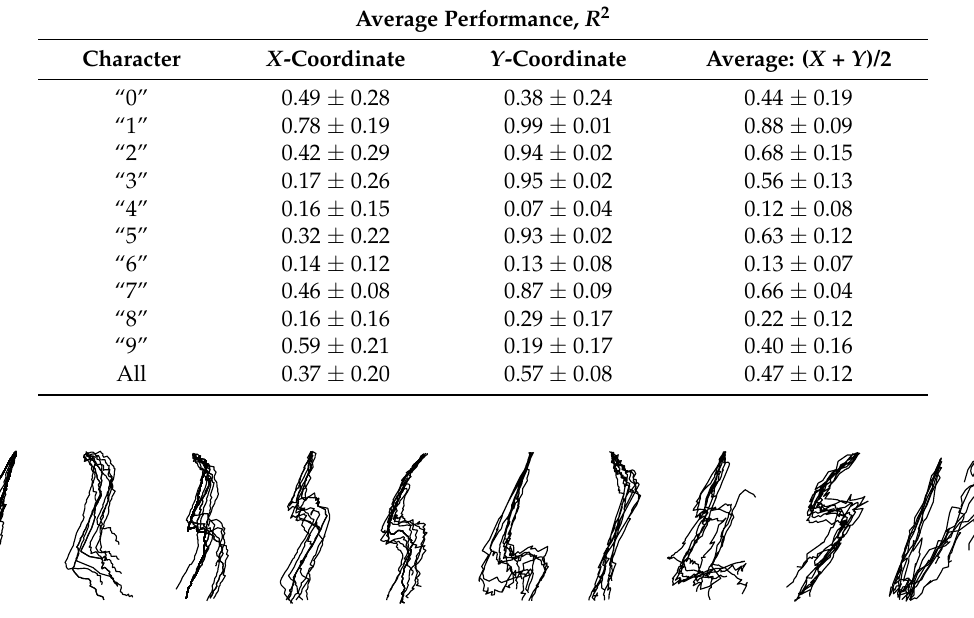
Figure 14. The randomly selected reconstructed numeric character of within-group reconstruction by the GEP. models. The average reconstruction accuracy of X -coordinate is 0.82 ± 0.13 and that of Y -coordinate is 0.74 ± 0.17, respectively higher than the results in within-group reconstruction. Figure 15 shows the reconstruction results of each shape from one participant. Compared with the unified models in within-group reconstruction, the separate GEP models for each shape perform